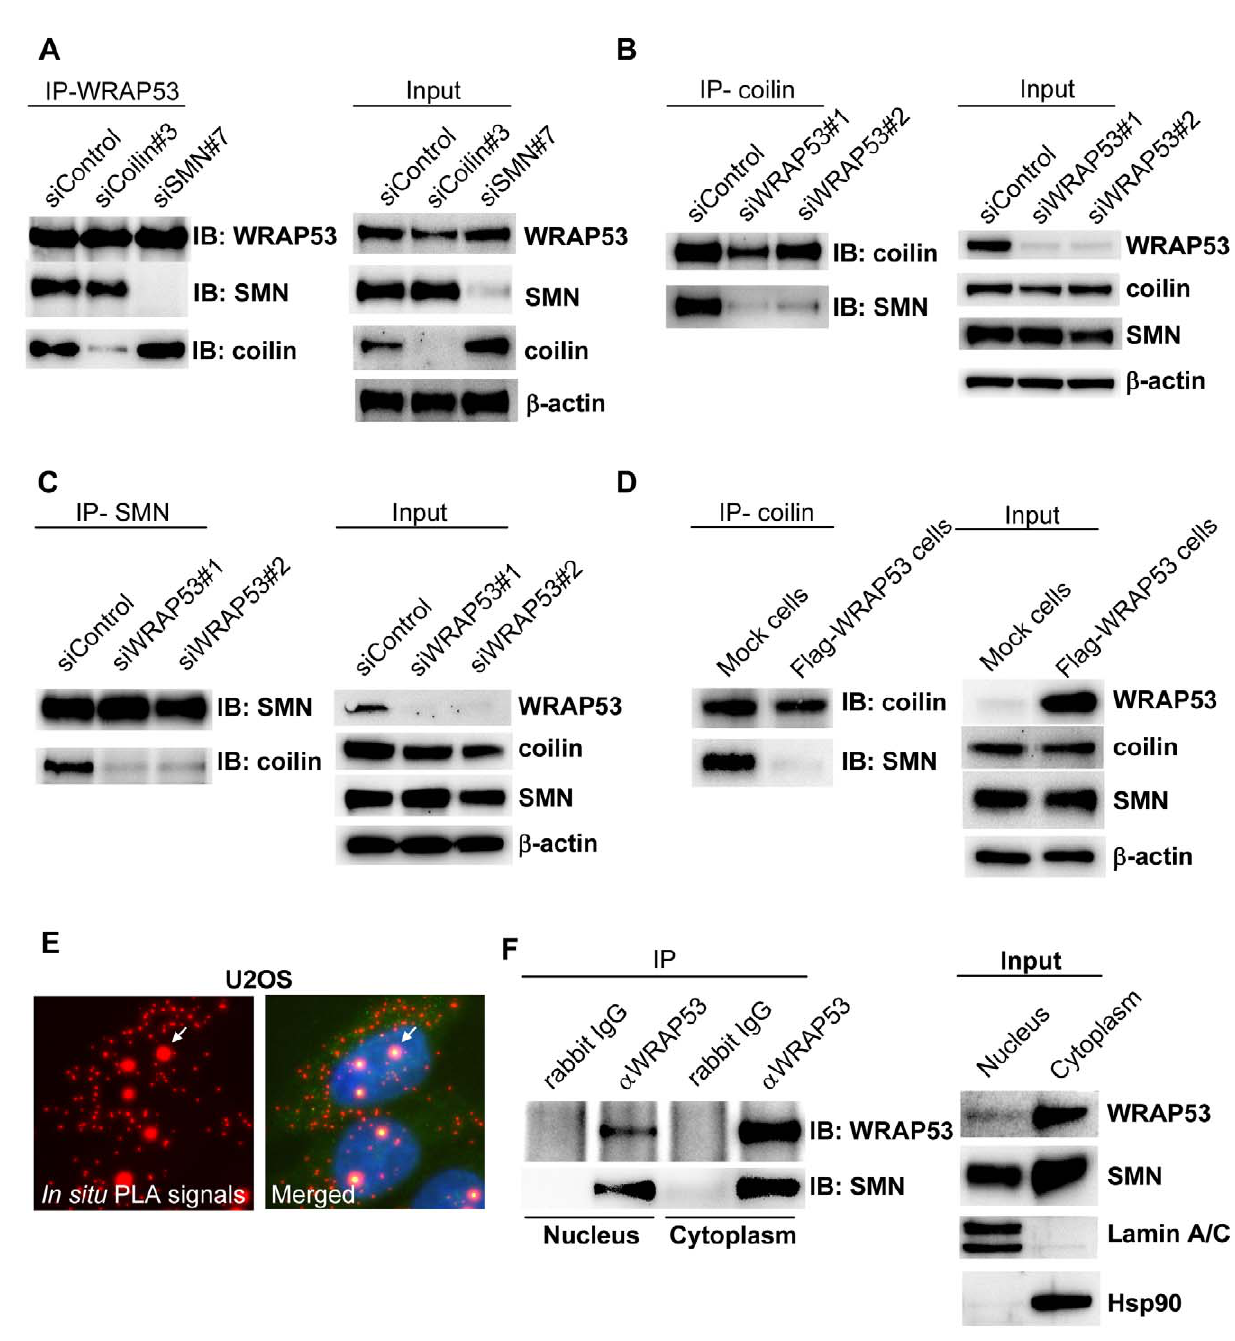
Figure 5. WRAP53 mediates coilin–SMN interaction and associates with SMN both in the cytoplasm and in the nucleus. (A–C) IP of endogenous WRAP53 (A), coilin (B), and SMN (C) from U2OS cells pretreated with the indicated siRNA oligos for 48 h. (D) IP of endogenous coilin from U2OS cells stably transfected with empty vector (Mock cells) or Flag-WRAP53 (Flag-WRAP53 cells). The Flag-WRAP53 cells express high levels of WRAP53 and show subsequent disruption of Cajal bodies (see Figure S4A). (E) In situ PLA detection of the interaction between WRAP53 and SMN in U2OS cells. Protein–protein interactions are visualized as small, distinct red spots. In Cajal bodies several in situ PLA signals are superimposed. Arrows indicate one Cajal body. (F) IP of endogenous WRAP53 from nuclear and cytoplasmic fractions of U2OS cells. G (Invitrogen) overnight at 4 u C. The beads were washed 4 6 for 15 min with 1 ml of NP40 buffer and prepared for WB.